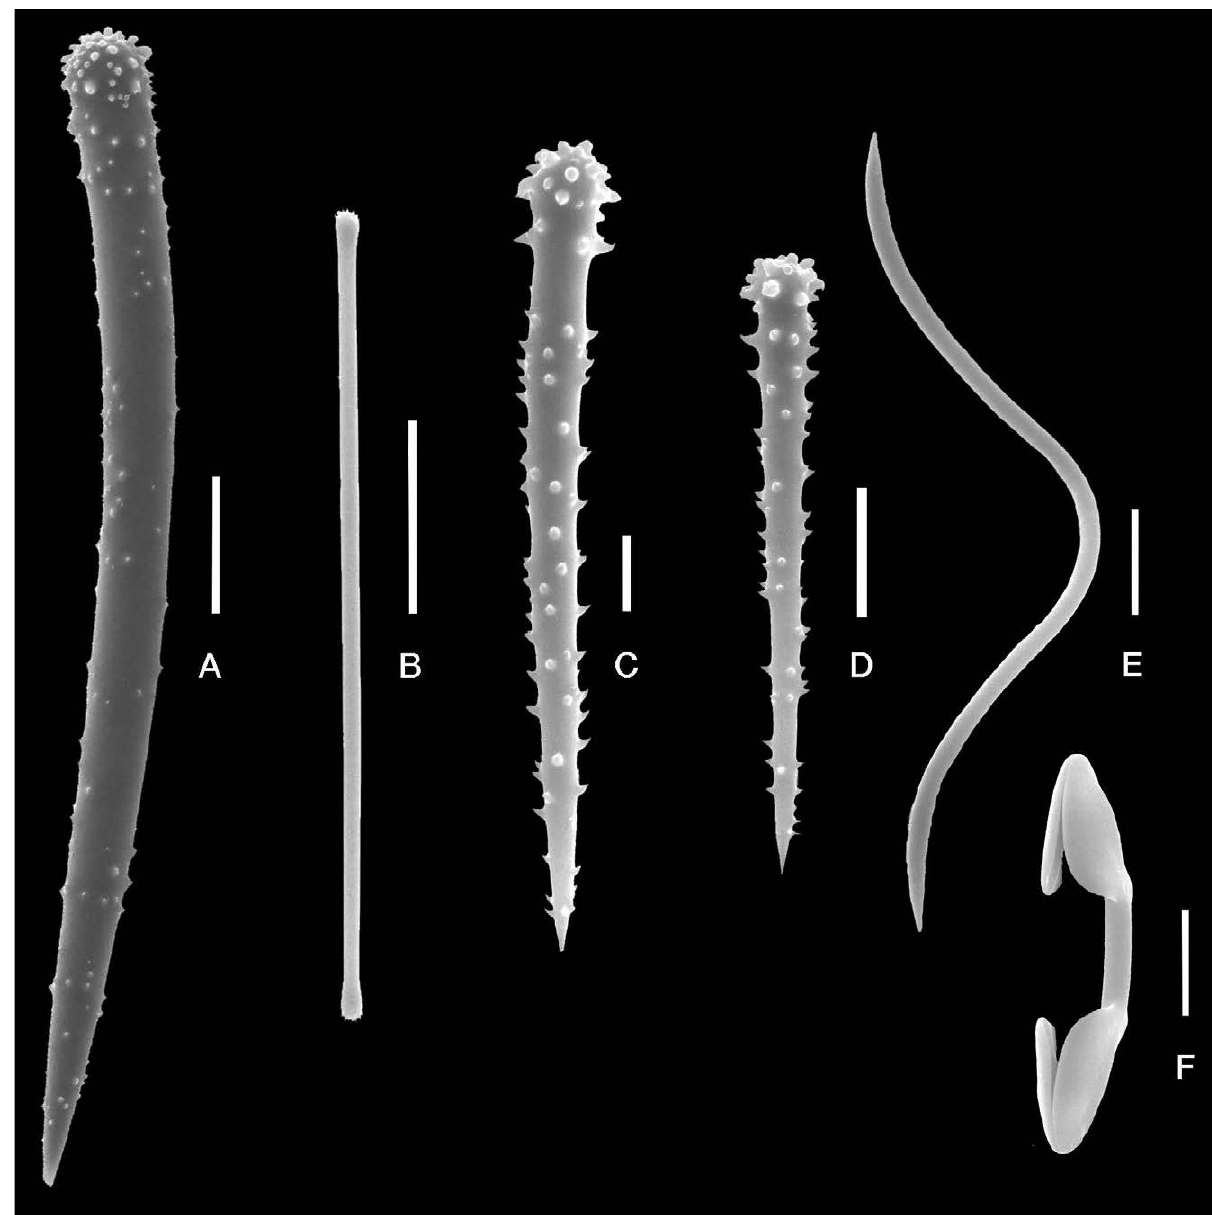
Fig . 10. – Megaciella microtoxa (Dickinson, 1945). A, Choanosomal acanthostyle. B, Ectosomal tylote with microspined heads. C, D, Echi- nating acanthostyle. E, Wing-shaped toxa. F, Palmate isochela. Scale: A, 40 μm; B, 60 μm; C, D, E, 15 μm; F, 3.5